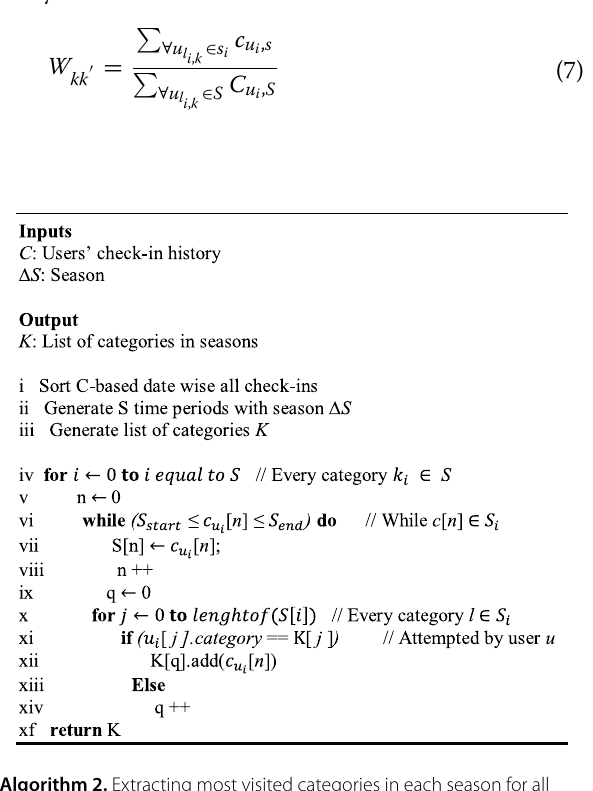
Algorithm 2. Extracting most visited categories in each season for all users Algorithm 2 helps to extract the most visited